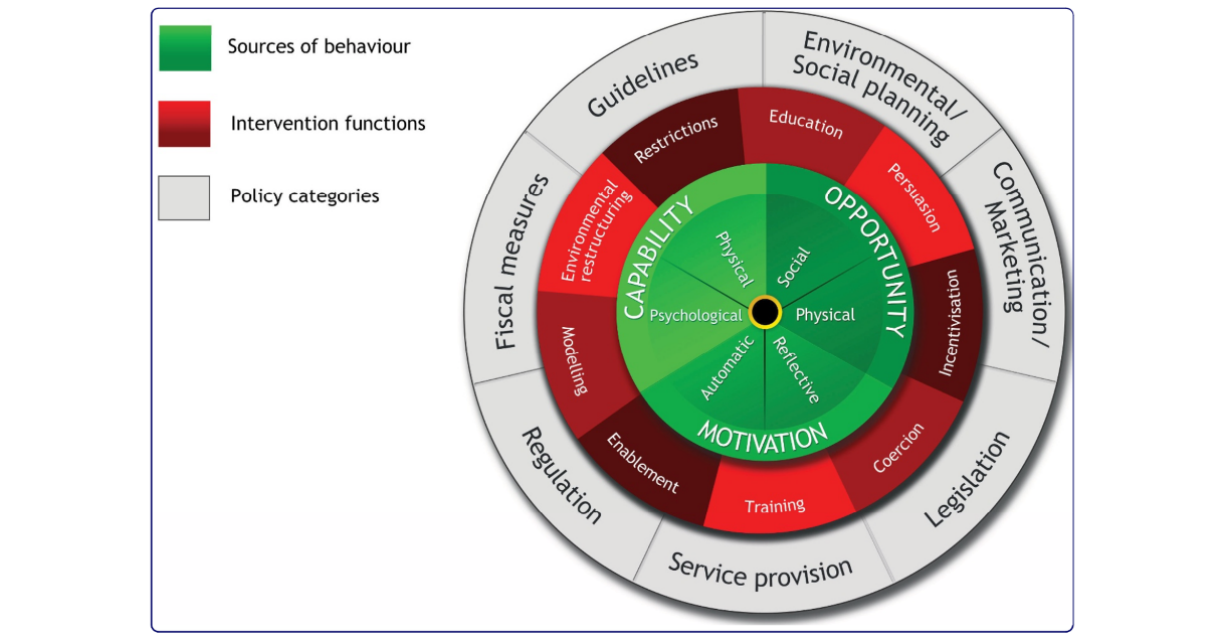
Figure 1. The behavior change wheel from reference Michie and colleagues